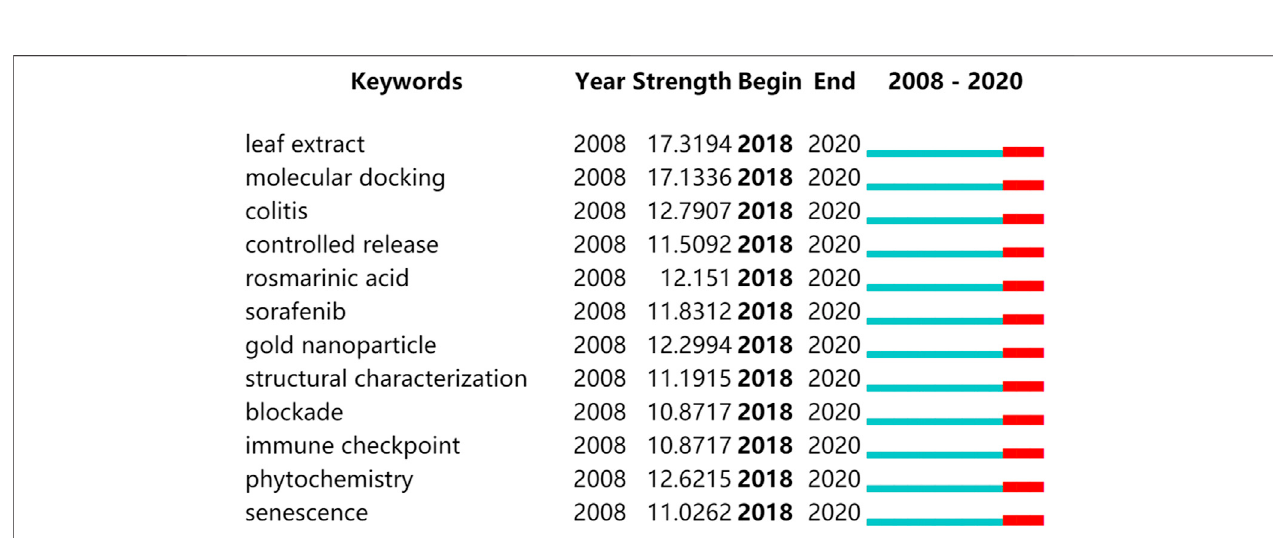
FIGURE 6 | Keywords with periods of burst from 2018 onward among the top 75 burst keywords in articles related to natural products in cancer research.